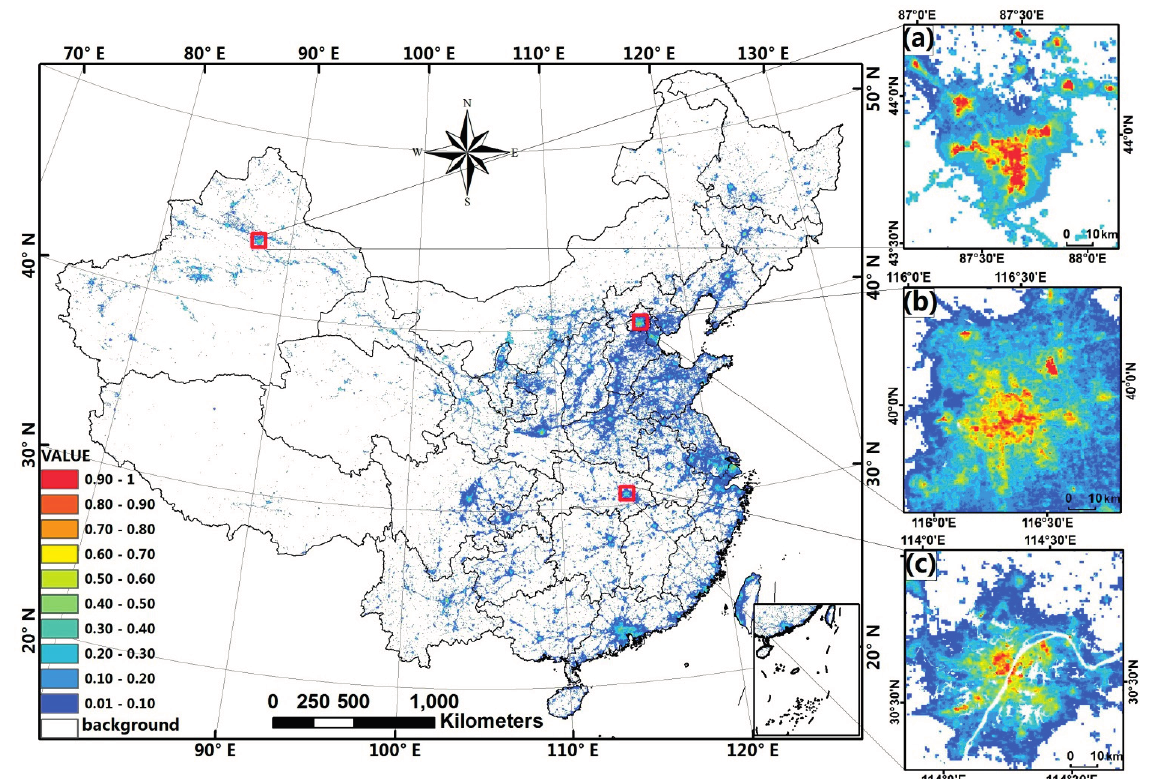
Figure 6. ISA distribution in China using the LISI-based model, highlighting the ISA spatial patterns from high ISA proportions in core urban areas to low proportions in rural regions; ( a ) Urumqi; ( b ) Beijing; and ( c )